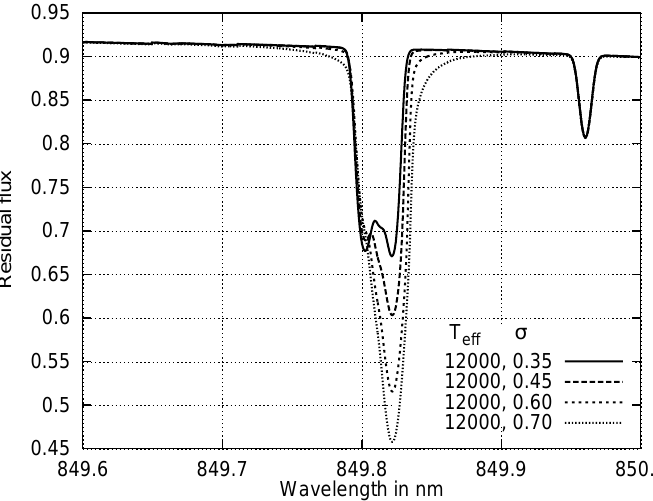
Fig. 9. The same as in Fig. 7, but for the 849.8 nm line. At larger values of (cid:27) the role of lighter isotopes on the line profile is less